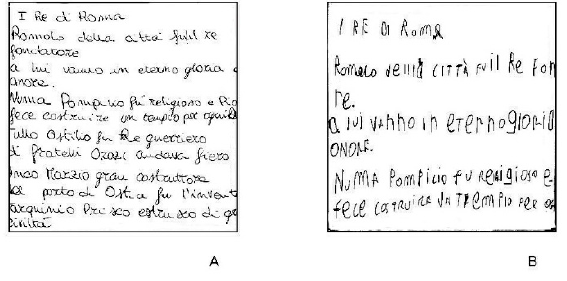
Figure 2. Handwriting samples: ( A ) Non-dysgraphic patient; ( B ) dysgraphic